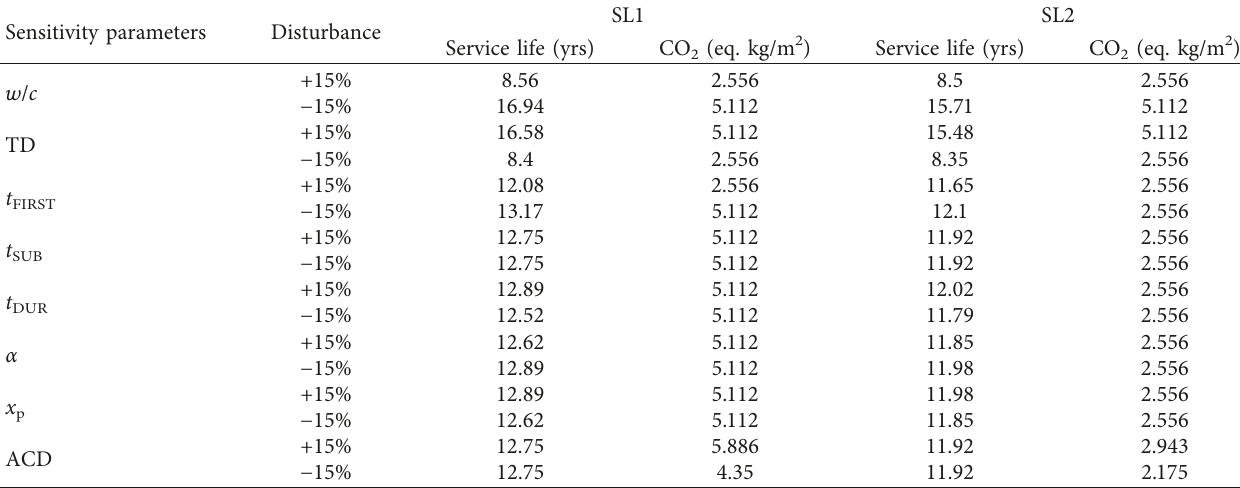
2 for ± 15% disturbances on sensitivity parameters.